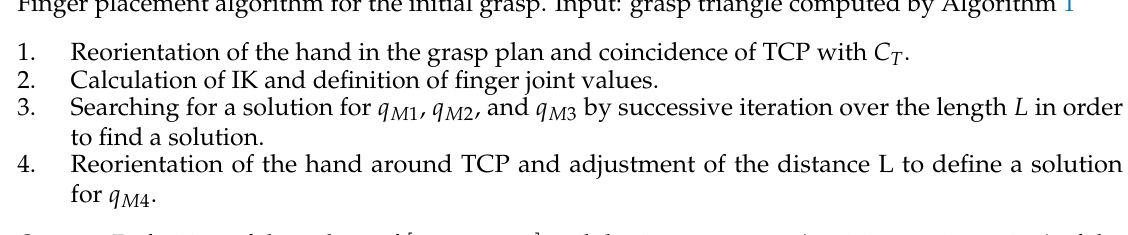
Algorithm 2 Pregrasp strategy for the robotic